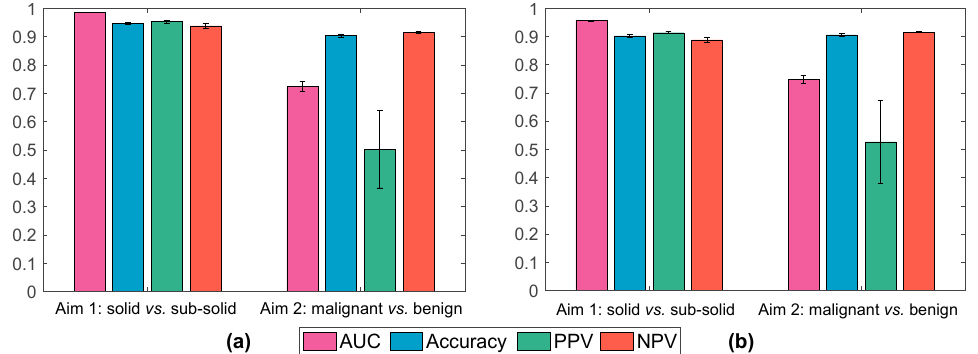
Figure 2. Classification results achieved by the radiomic classifiers for Aim 1 (PN characterization) and Aim 2 (PN risk) based on the Elastic Net on the discovery dataset by using ( a ) informative, non- redundant radiomic features, and ( b ) only the most frequently selected radiomic features. The bar graph and error bars denote the average value and the variability across 50 repetitions, respectively.